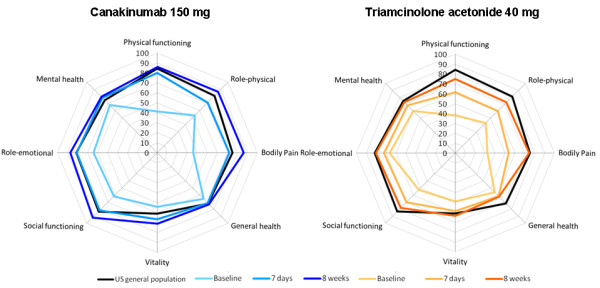
Spidergrams showing HRQoL improvement (SF-36 scores): canakinumab 150 mg (A); triamcinolone acetonide 40 mg (B). Acute version 2 of SF-36, 36-item Short-Form Health Survey; HRQoL, health-related quality of life.